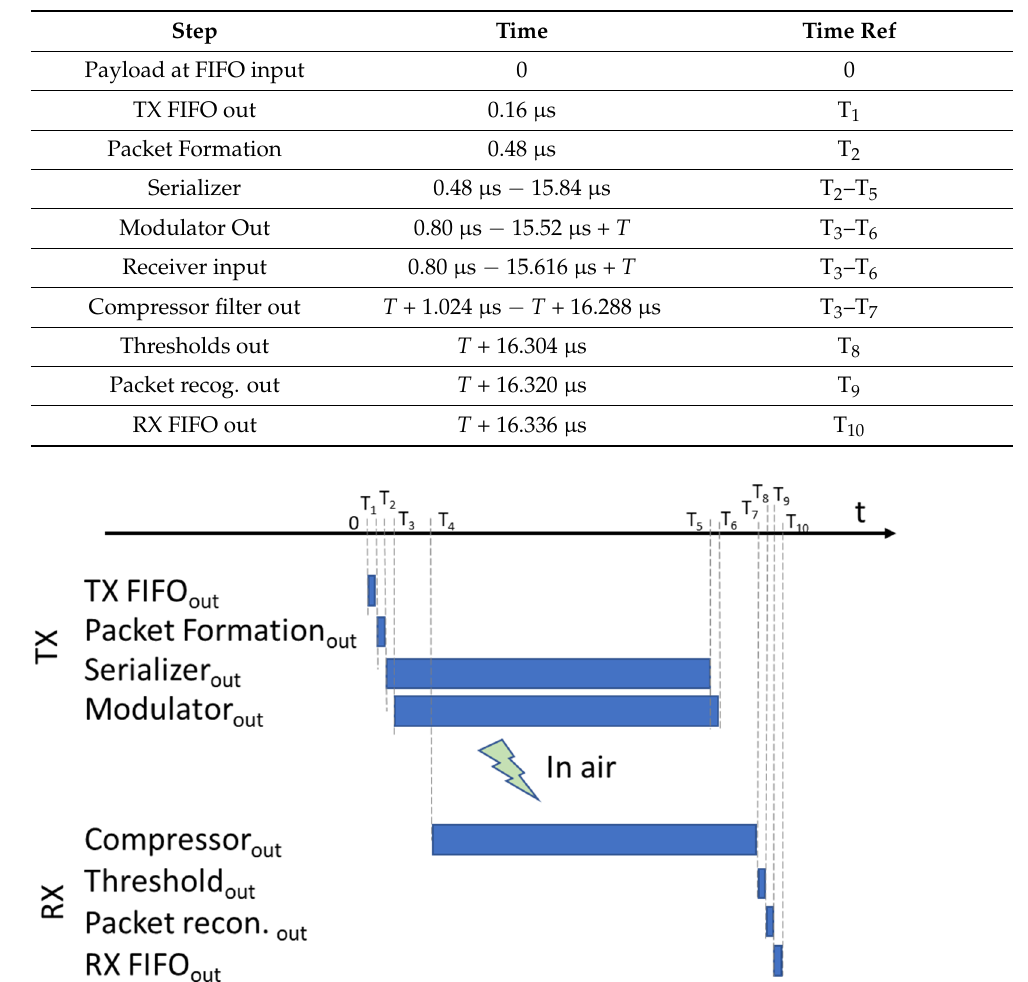
Figure 13. Delays (not to scale for clarity) in the TX and RX processing chain. The time-bars referrer to the output of the corresponding block.